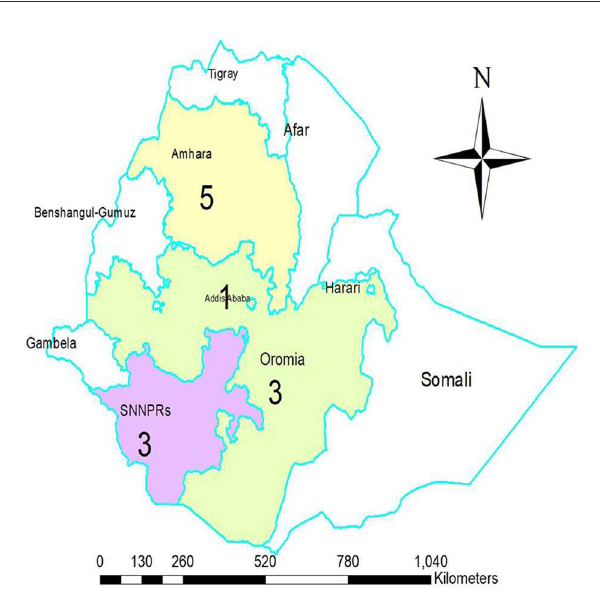
FIGURE2 The map displays regions or city council where the primary studies included in the quantitative synthesis were conducted.